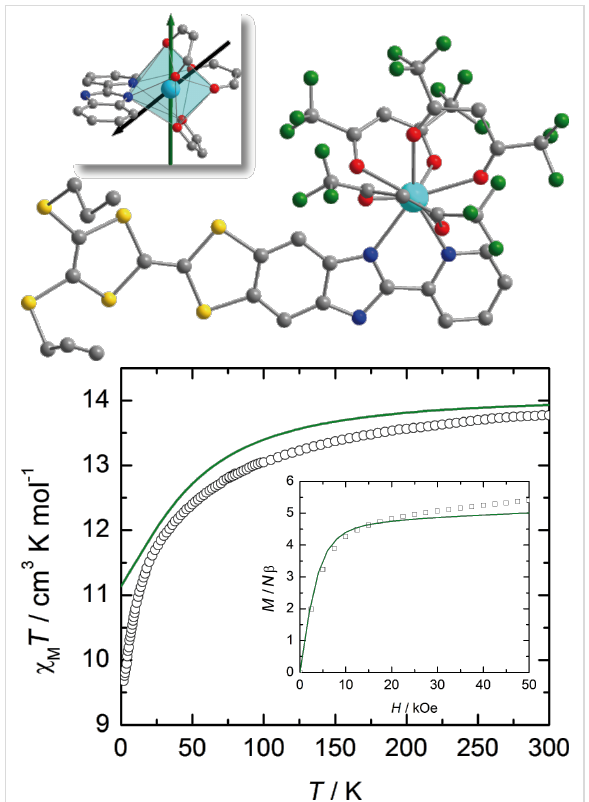
Figure 1: Molecular structure of Dy1 (top). Dy, O, N, C, S and F atoms are depicted in light blue, red, blue, grey, yellow and green, respective- ly. H atoms are omitted for clarity. Inset: Experimental (black) and theoretical (green) ground state anisotropy axes are shown on the coordination polyhedron. Thermal variation of χ M T of a solid-state sample of Dy1 (black circles) with the curve (in green) calculated on the basis of SA-CASSCF/RASSI-SO data (bottom). Inset: field varia- tion of the magnetization at 2 K (black squares) with the computed curve (in green) obtained at the same level of calculation.